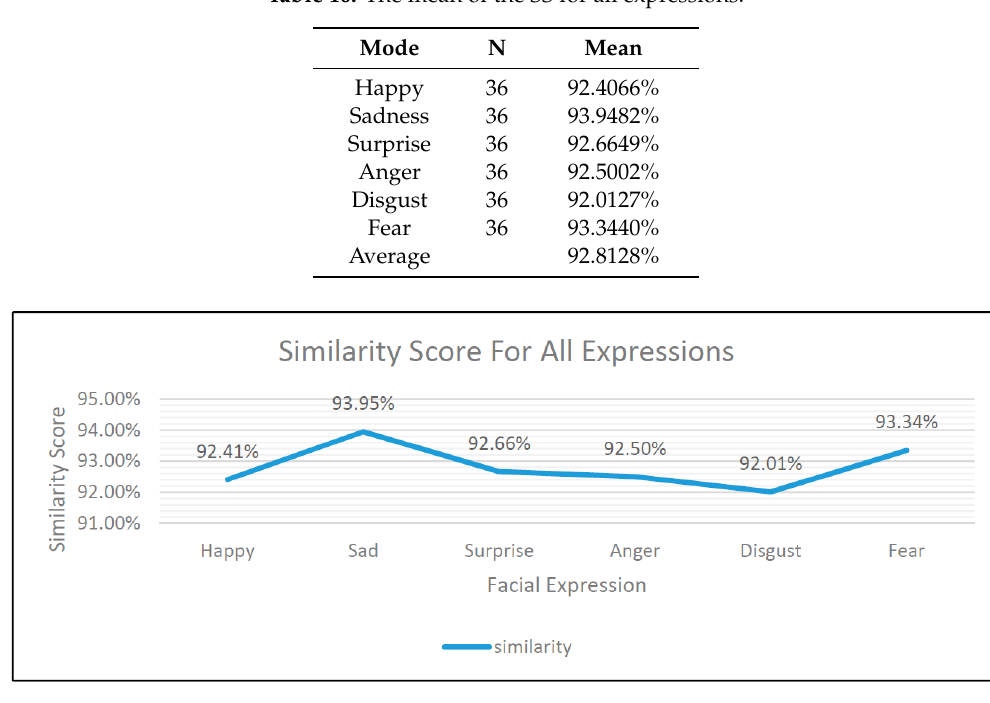
Figure 21. SS means plot of the 6 FE of 36 subjects in comparison to the neutral mode.